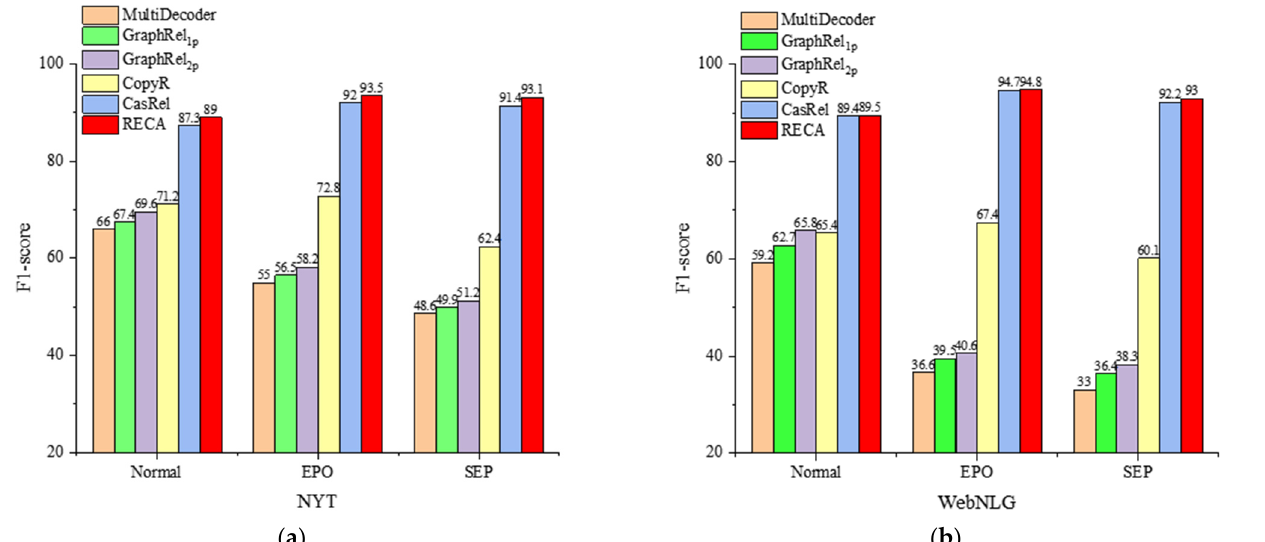
Figure 4. ( a ) The F1-score for the extraction of relational triplets from sentences with different overlapping problems from the NYT dataset and ( b ) the F1-score for the extraction of relational triplets from sentences with different overlapping problems from the WebNLG dataset. Table 2. Experimental results for different models and the NYT and WebNLG datasets. Our re-implementation is marked by *. The best scores are in bold font.